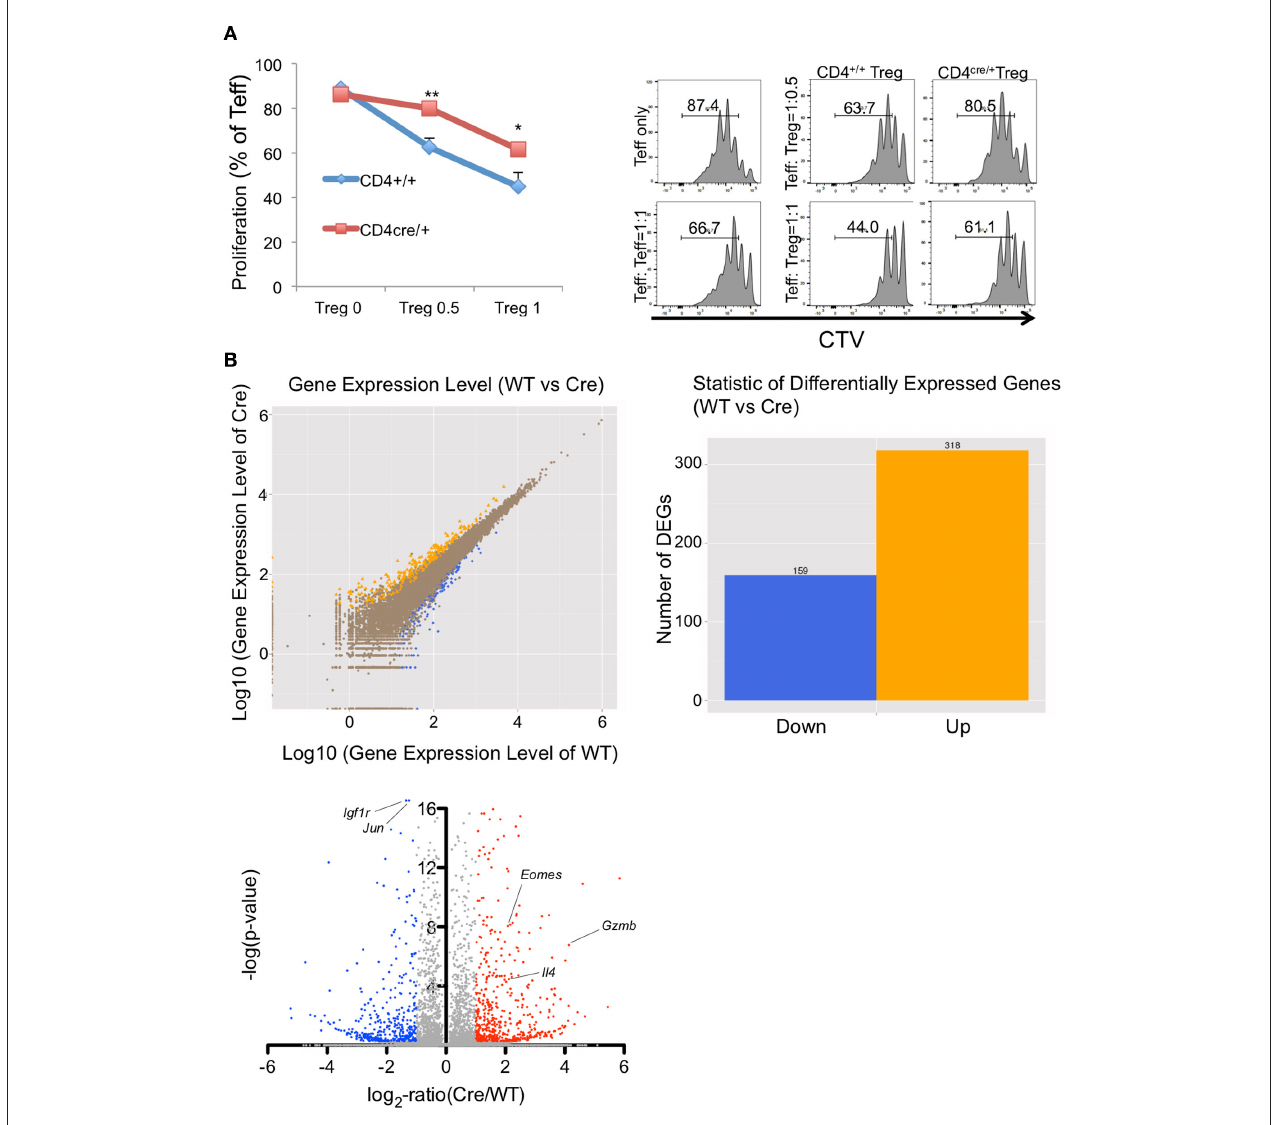
FIGURE 4 | Functional and RNA sequencing analysis of PRMT5-deleted Tregs. (A) functional analysis of CD4 cre / + -PRMT5 fl / fl Tregs. CD4 + / + and CD4 cre / + -PRMT5 fl / fl Tregs were sorted as CD4 + CD25 high CD45RB low cells and used for the Treg suppression assay as described above. CTV-labeled CD4 + CD25 low CD45 high cells from CD4 + / + PRMT5 fl / fl cells were used as effector cells. The error bars indicate the SD value. * P < 0.05, ** P < 0.01 with CD4 + / + groups calculated by student t -test. (B) differential gene expression between WT (CD4 + / + -PRMT5 fl / fl ) and Cre (CD4 cre / + -PRMT5 fl / fl ). Two mice per group were subjected for